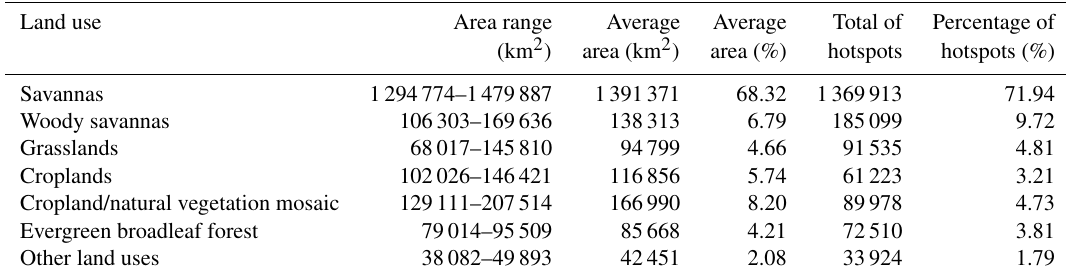
Table 2. Area range (km 2 ) and average area (km 2 , %) of the LULC classes in the Cerrado biome estimated by the MCD12Q1 product during the 2002–2013 period, and total and percentage of hotspots detected by the MODIS active fires products in the LULC classes of the Cerrado during the 2002–2015